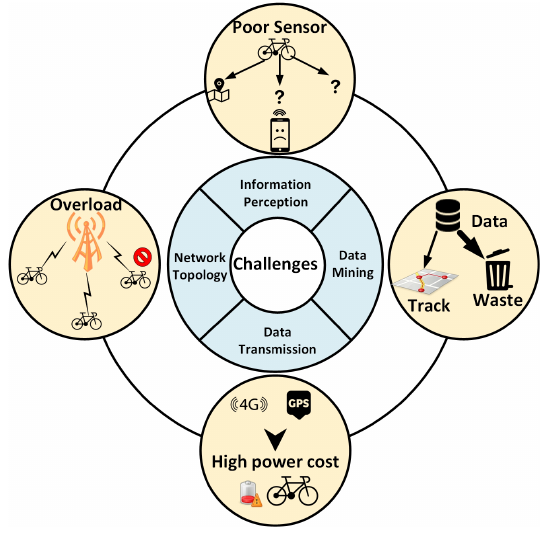
Figure 8. Challenges of